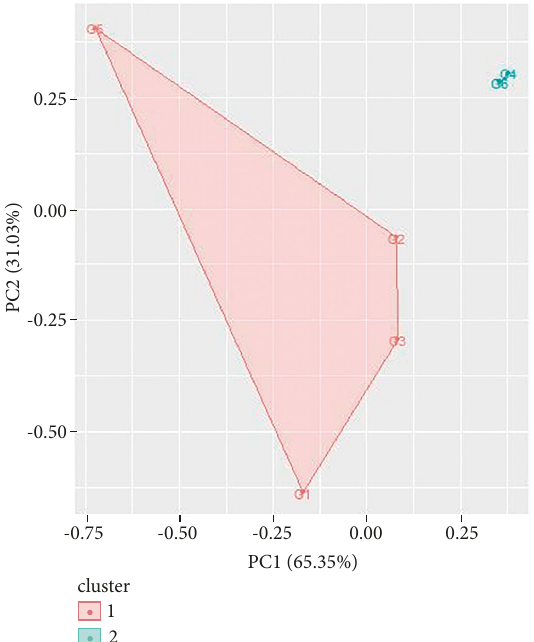
Figure 16: Cluster analysis for FTIR spectroscopy data for green ballpoint pen